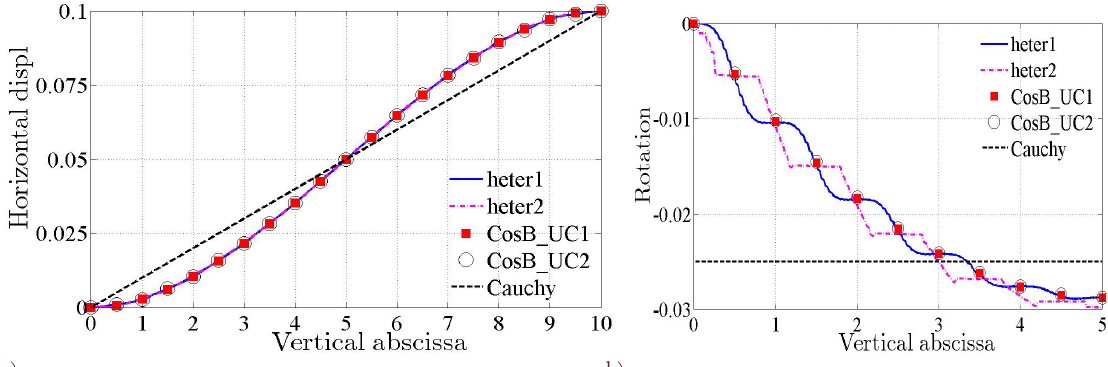
Figure 5: a) Horizontal displacement versus vertical abscissa; b) Rotation versus vertical